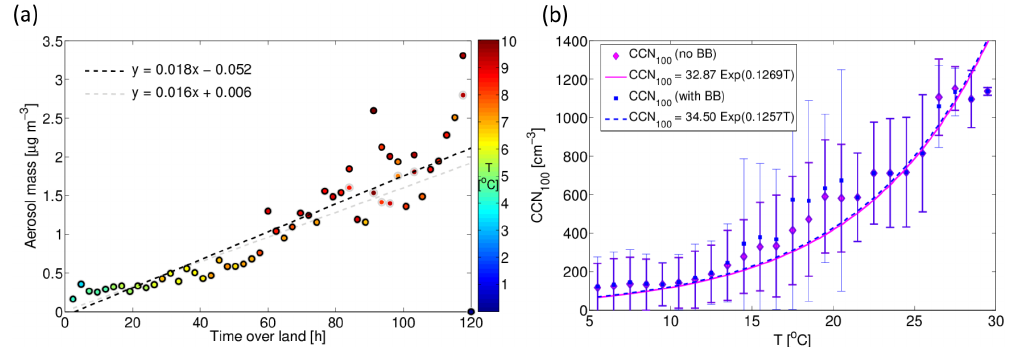
Figure 10. Panel (a) : average aerosol total mass ( ≤ 500nm) as a function of air mass time spent over land. Circles with grey borders present all data and circles with black borders data without significant BB influence (i.e., data belonging to mass clusters indicative of biomass burning are not used; for reference, see Fig. 5b). Colors inside circles indicate the average temperature for each point. Dashed grey and black lines show the linear fits ( R 2 = 0 . 84 for all data; R 2 = 0 . 88 for no BB) to data points along with the fitting equations. Panel (b) : average CCN 100 concentration calculated from all data (blue squares) and from data without significant BB influence (purple diamonds), plotted as a function of outdoor air temperature, with an exponential fits to the data ( R 2 = 0 . 97 for all data; R 2 = 0 . 98 for no BB). Bars represent the standard